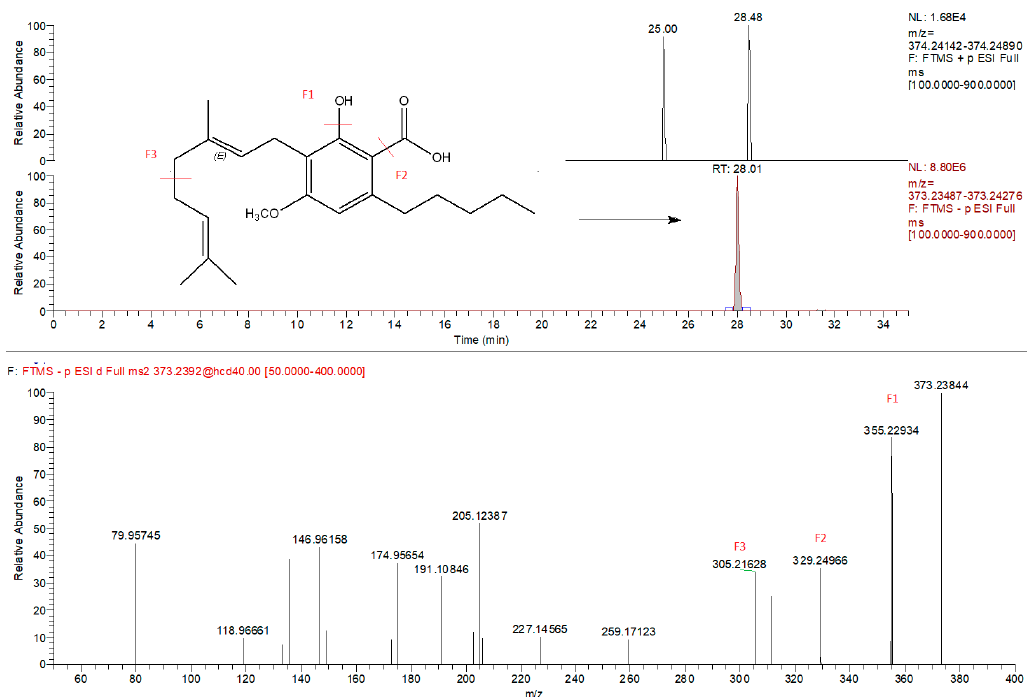
Figure 1. Extracted ion chromatogram ( m/z = 373.2384) of CBGMA (cannabigerolic acid methyl ester) and corresponding MS/MS spectra identified exclusively in negative mode.